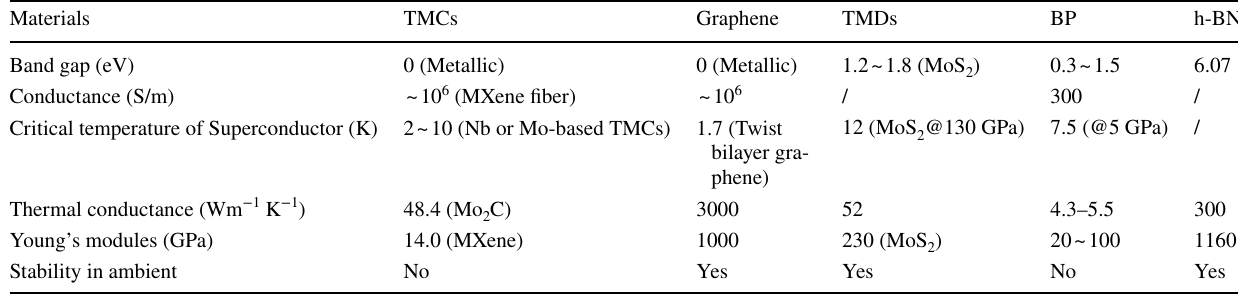
Table 2 Basic parameters of the typical layered materials Materials TMCs